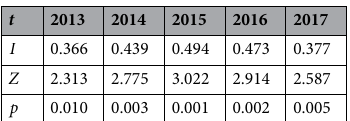
Table 5. Moran’s I index, from 2013 to 2017. Confidence level: 0.99.